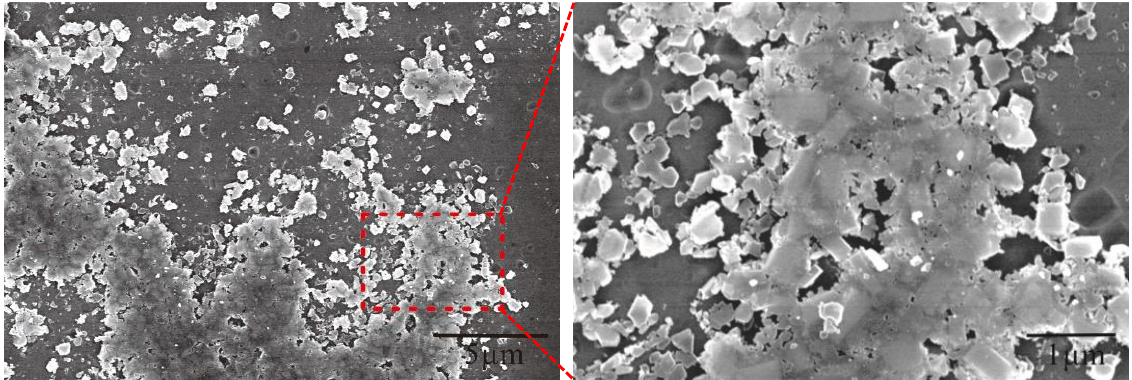
Figure 13. SEM of the “rich Ti, B area” and TiB 2 in the Al–Ti–B Master Alloy prepared by the halide salt route at 800 °C for 60 S.